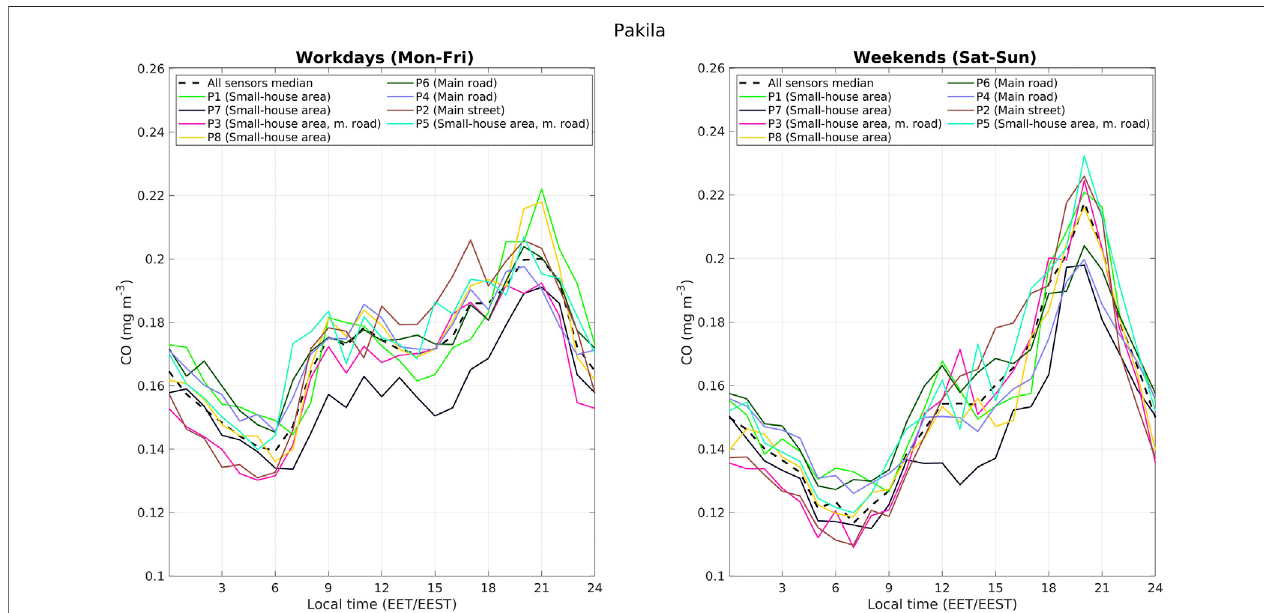
FIGURE 12 | Median diurnal cycles of CO during 1.1.-28.2.2021 for sensors located in Pakila (left) workdays (Mon-Fri) and (right) weekends (Sat-Sun). Black dashed line shows median diurnal cycle calculated for all data from that